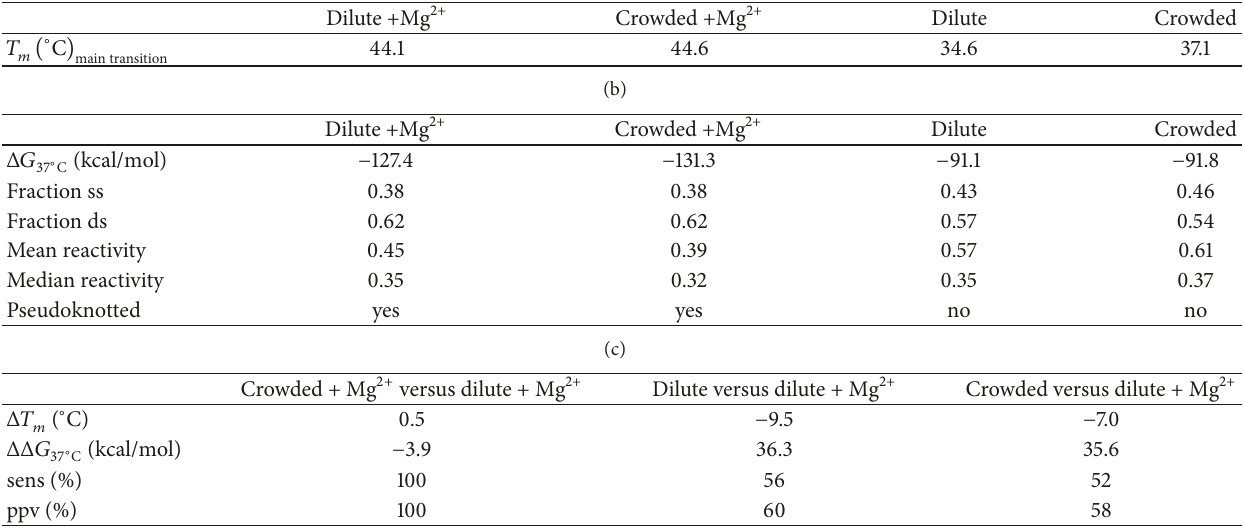
Table 1: (a) Helix/coil transition temperatures ( 𝑇 𝑚 ) of the T. brucei RPS12 pre-mRNA derived from the denaturation profiles shown in Figure 1. Macromolecular crowding was mimicked by 6% (w/w) PEG 4000 . (b) Summary of SHAPE-derived Gibbs free energies ( Δ𝐺 ) and structural characteristics of the RPS12 transcript in dilute and crowded solvent conditions. In addition, mean and median SHAPE reactivities are provided. (c) Structural features of the RPS12 pre-mRNA in crowded and/or Mg 2+ -free solvent conditions compared to dilute solvent conditions at 2mM Mg 2+ . ΔΔ𝐺 : difference Gibbs free energies; sens: sensitivity; ppv: positive predictive value. For a comprehensive comparison, see Table